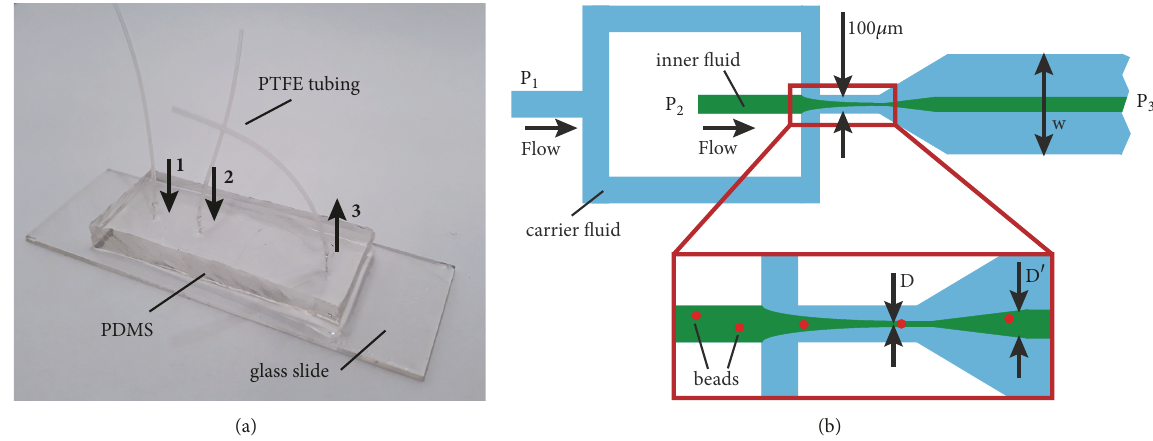
Figure 1: (a) Picture of the microfluidic device presenting inlets (1,2) and outlet (3). (b) Scheme of the microfluidic device: the carrier liquid (light blue) confines the inner fluid (green) that contains the PS beads (red spots). The scheme shows that the focusing is more efficient in the channel region (D) than in the chamber part (D 󸀠 ). P 1 , P 2 , and P 3 are the pressure corresponding to the inlets/outlet shown in